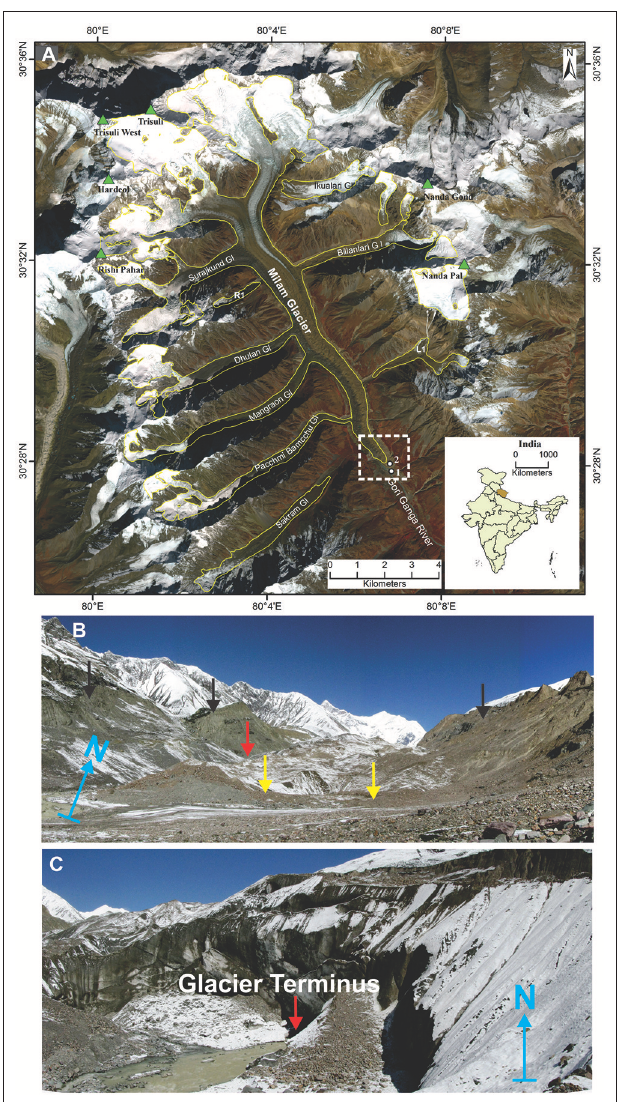
FIGURE 1 | (A) Location of the Milam glacier in India. The yellow outline on the Sentinel 2 satellite image shows the boundary of the Milam glacier in 2017. The L1 and R1 indicate un-named left bank and un-named right bank tributary glaciers, respectively. The two white dots marked 1 and 2 show the locations of photographs (B) and (C) taken in 2009, respectively; (B) lower ablation zone and outwash plain with glacier terminus (red arrow), lateral (black arrows), and recessional moraines (yellow arrows) and (C) the terminus of the Milam glacier with debris